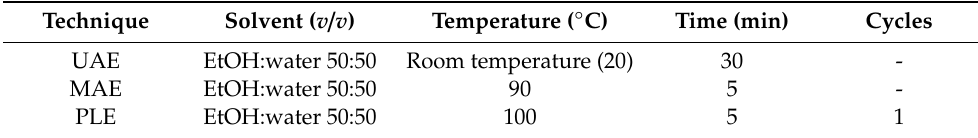
Table 2. Selected conditions, for polyphenol extraction from olive oil and wine industries wastes.